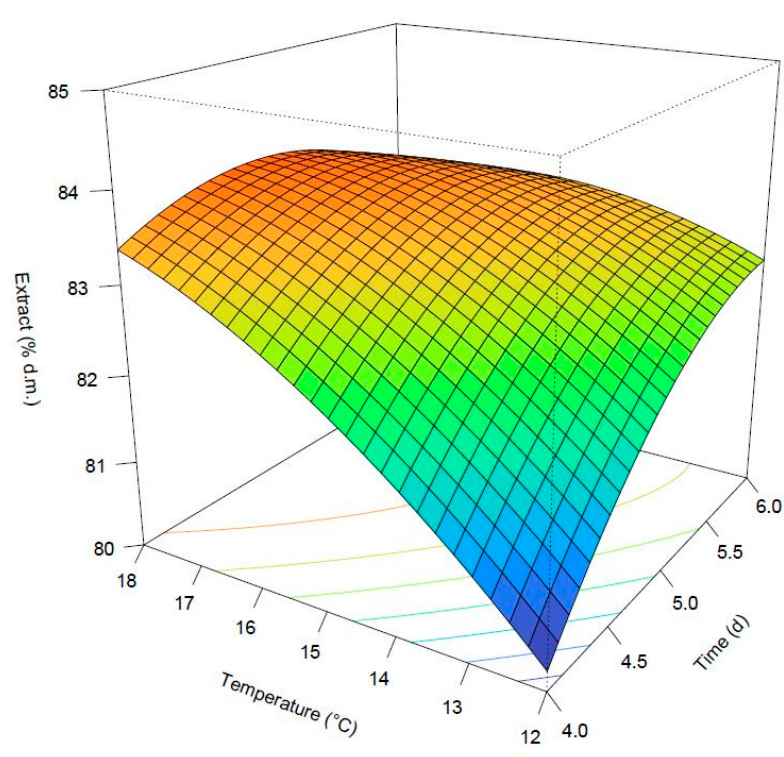
Figure 2. Surface plot of the predicted extract.